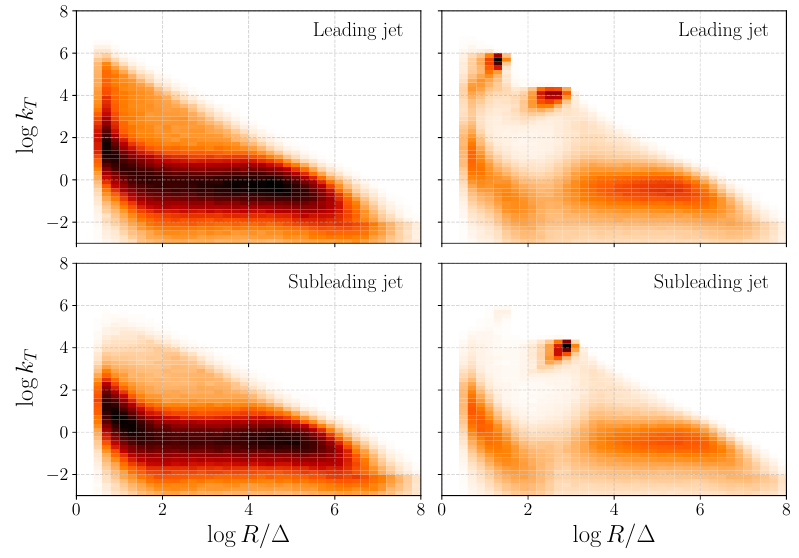
Figure 8 . Distributions of QCD (left) and W 0 (right) di-jet events in the (log k See text for